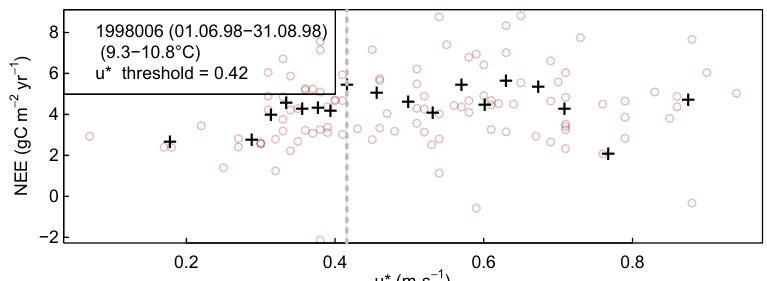
Figure 2. Concept of the u ∗ filter: nighttime NEE at low u ∗ is biased towards lower NEE values compared to cases with higher u ∗ . Unbiased NEE should scatter around the same plateau because environmental conditions are similar. The u ∗ threshold (dashed line), i.e., the value below which this bias is considered significant, is estimated by a moving point method on u ∗ bins (crosses) across half-hourly records (circles). The example uses a subset of data from